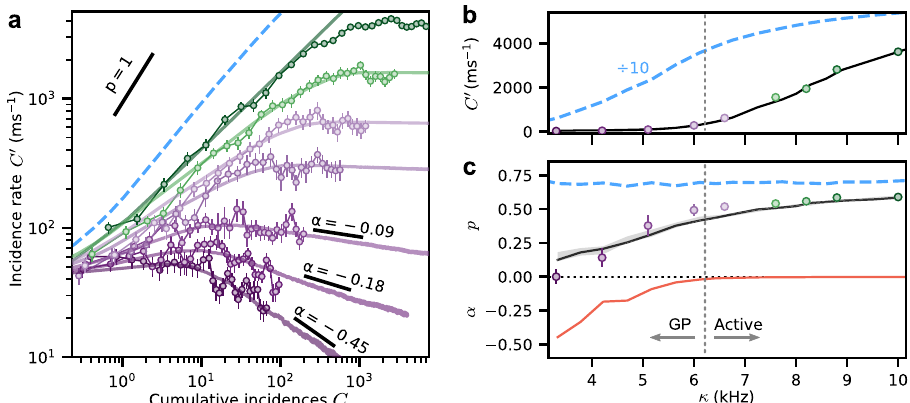
Fig. 2 Rydberg excitation incidence curves for different facilitation rates showing power-law growth and Grif fi ths effects. a Incidence rate C 0 versus cumulative incidences C for different facilitation rates κ = {3.3, 4.2, 5.1, 6.0, 6.6, 7.6, 10} kHz (from purple to green). Error bars show the standard error of the mean over typically 16 repetitions of the experiment. The straight dark green line is a power-law fi t to a representative dataset yielding the exponent p = 0.59(1). The solid curves are from the simulations of the SIS model on a heterogeneous network and the blue dashed line is a corresponding simulation for a locally homogeneous network for κ = 10 kHz and a comparable system size which gives p ≈ 0.67. b Transition from a subcritical state ( C 0 (cid:2) 0) to an active state ( C 0 > 0) at late times t = 2 ms as a function of κ . The solid black curve and the dashed blue curve (scaled by a factor of 10 for visual comparison) show simulations of the heterogeneous and locally homogeneous network models, respectively, which exhibit different thresholds and incidence rates. c Characterization of the deceleration of growth parameter p (experimental data points and simulations as a black line) and power-law relaxation exponent α (orange line, numerical simulations only) versus κ . The vertical dashed line indicates the cross-over point between the Grif fi ths phase (GP) and the active phase. Uncertainties computed from the standard deviation over 100 bootstrap resamplings are shown as error bars except where they are smaller than the data